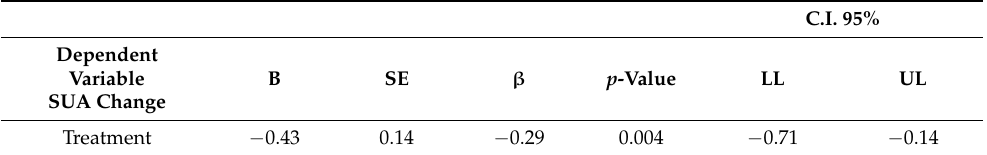
individuals with Non-Alcoholic Fatty Liver Disease Table 3. Multivariable linear regression analysis – Factors associated with absolute SUA change in